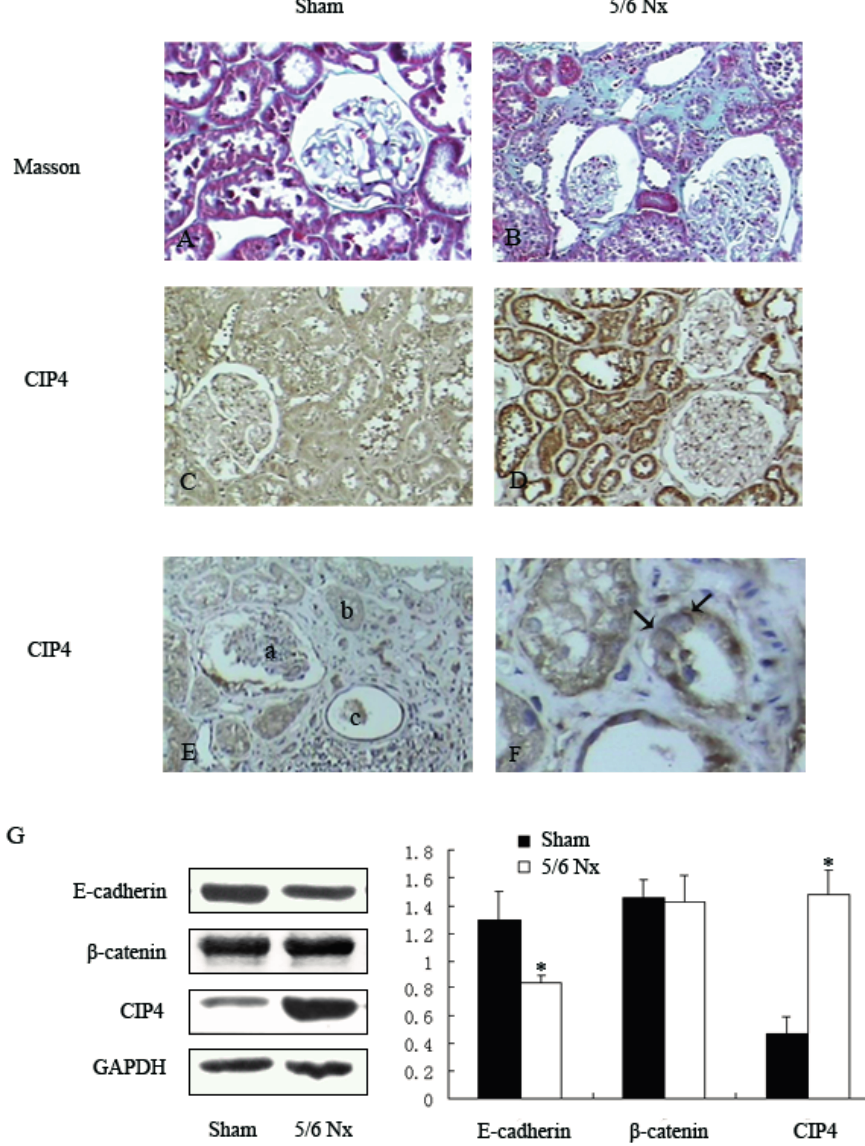
Figure 1. Expression and distribution of CIP4 in fibrotic renal tissue of rats: ( A , B ) analysis of tissue fibrosis by staining of kidney sections with Masson’s trichrome stain, 200×; ( C , D ) immunohistochemical analysis of CIP4 expression in the renal tissue of 5/6 nephrectomized and sham-operated rats, 200×; ( E ) representative staining of CIP4 distribution in the area of the glomerulus (a), renal tubule (b) and blood vessel (c), 200×; ( F ) CIP4 is mainly distributed at the basolateral side of epithelial cells (black arrows), 400×; and ( G ) Western blot of E-cadherin, β -catenin, and CIP4 in renal tissues of sham-operated and 5/6 nephrectomized rats. The histogram shows the average volume density normalized to the loading control GAPDH, ( n = 3); * p < 0.05 compared with sham-operated